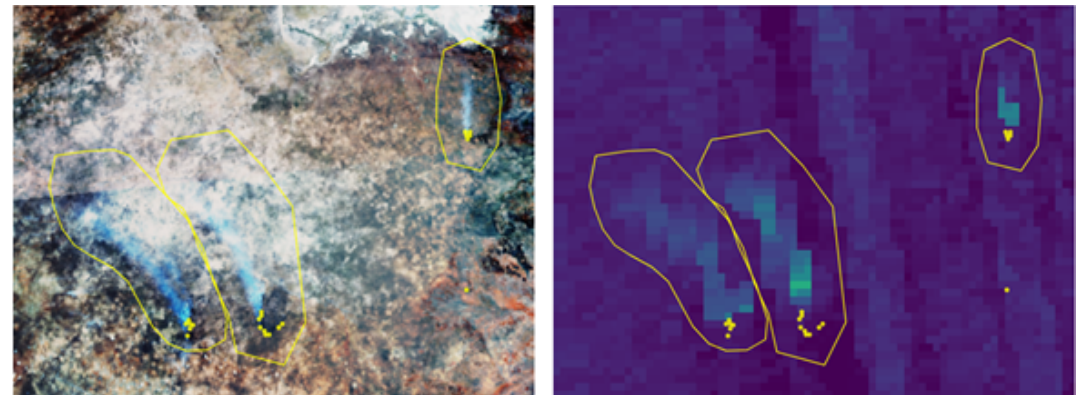
Figure 1. Example data of match-up fires used to develop the C CO e smoke emissions coefficients presented in Fig. 2. (a) VIIRS RGB image of three landscape fire smoke plumes, along with (b) the corresponding image of Sentinel-5P derived total column CO (TCCO). In both images, the AF pixel detections taken from the Meteosat FRP-PIXEL product are superimposed (yellow points), along with the bounding polygons used to delineate the fire plumes. Satellite data are from 11:24 and 11:30UTC, respectively, on 9 September over an area in northern